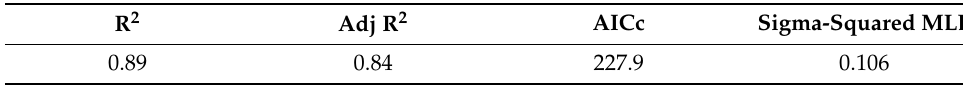
Table 6. Calculation Results of GWR Model—Residents. R 2 Adj R 2 AICc Sigma-Squared MLE 0.89 0.84 227.9